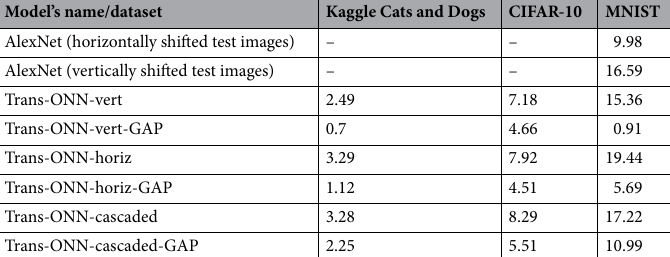
Table 4. Standard deviation of classification accuracies for each network model.